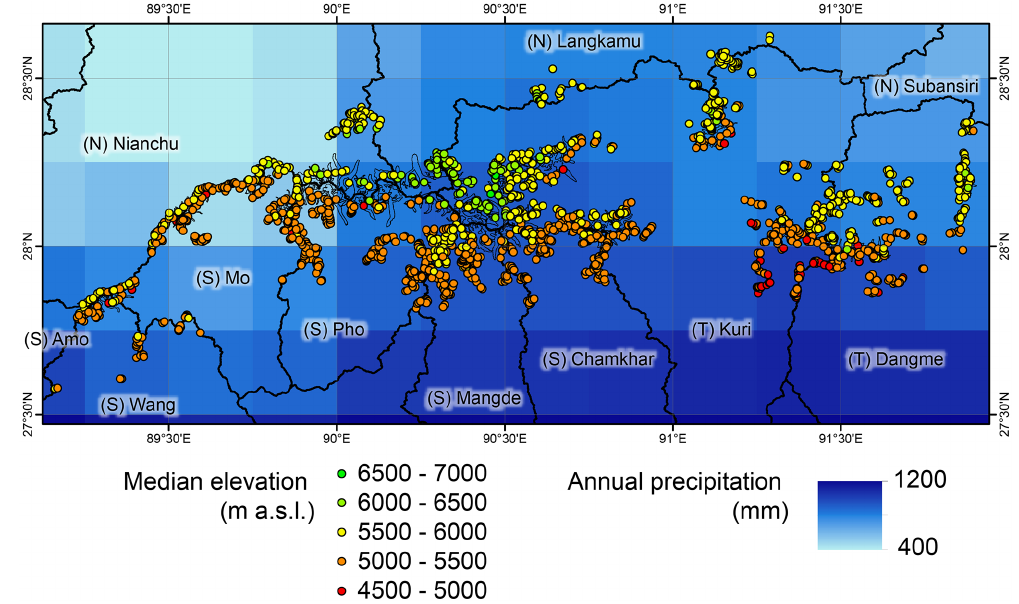
Figure 11. Spatial distributions of median elevation for the ALOS-derived glacier outlines, overlain on the spatial distribution of annual precipitation from TRMM 3B43 data (1998–2014). Table 3. Surface area and overlap ratios for the whole glacier surface in the Bhutan Himalaya among the six inventories, in which one inventory represents one glacier surface. The numbers in italic font denote overlapped area (km 2 ). Combination of ALOS GAMDAM ICIMOD RGI4.0 RGI5.0 glacier inventory Total area 1487 1453 1696 2261 1510 (km 2 ) ALOS 1487 1276 1371 GAMDAM 1453 0.87 ICIMOD 1696 RGI5.0 Overlap ratio (0 to